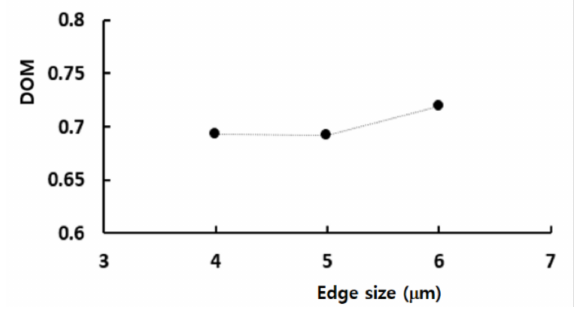
Figure 8. Grid independence